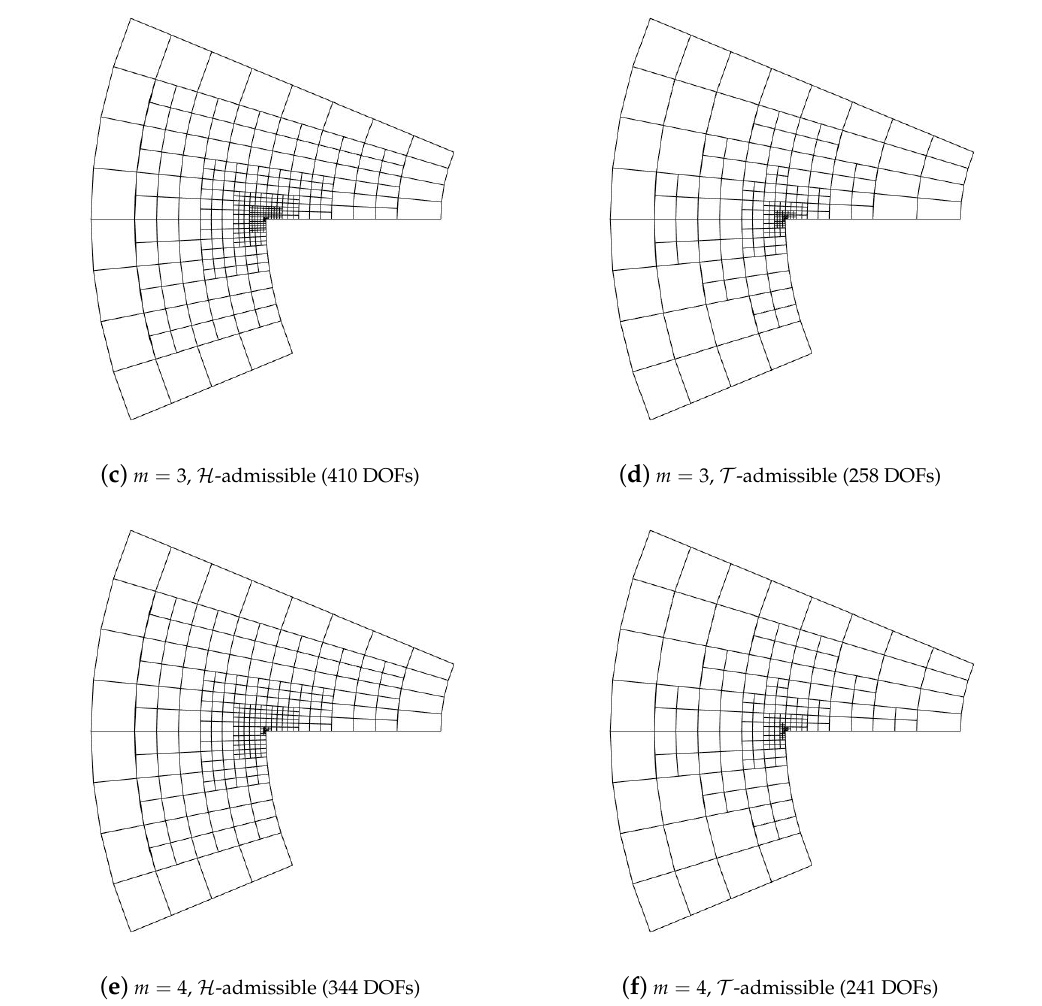
Figure 9. Hierarchical meshes obtained with p = ( 2,2 ) and m = 2,3,4 (from top to bottom ), by using H -admissible ( left ) and T -admissible ( right ) meshes.